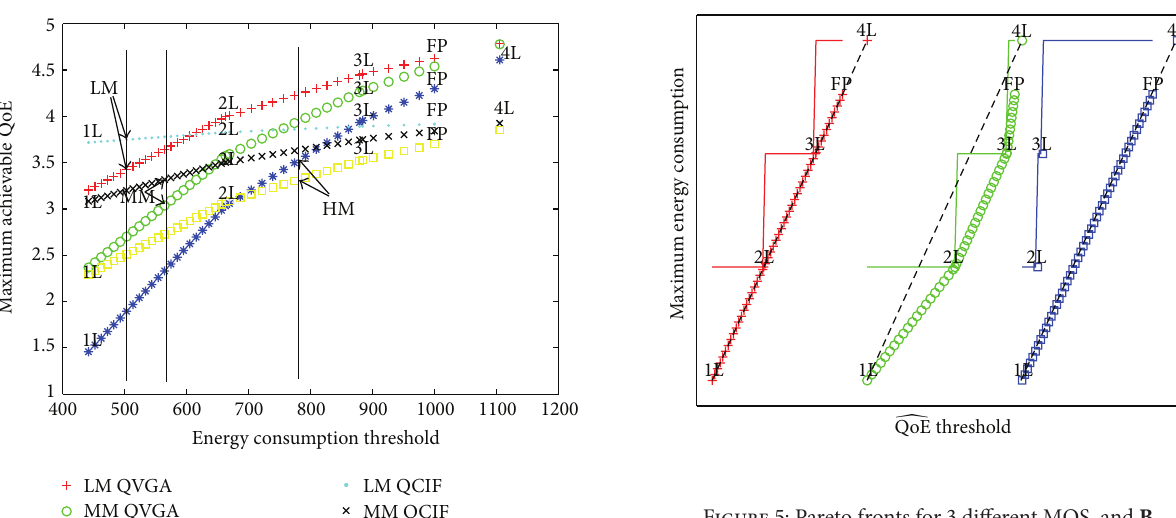
Figure 5: Pareto fronts for 3 different MOS 𝑖 and B . optimal points (i.e., they do not belong to the Pareto